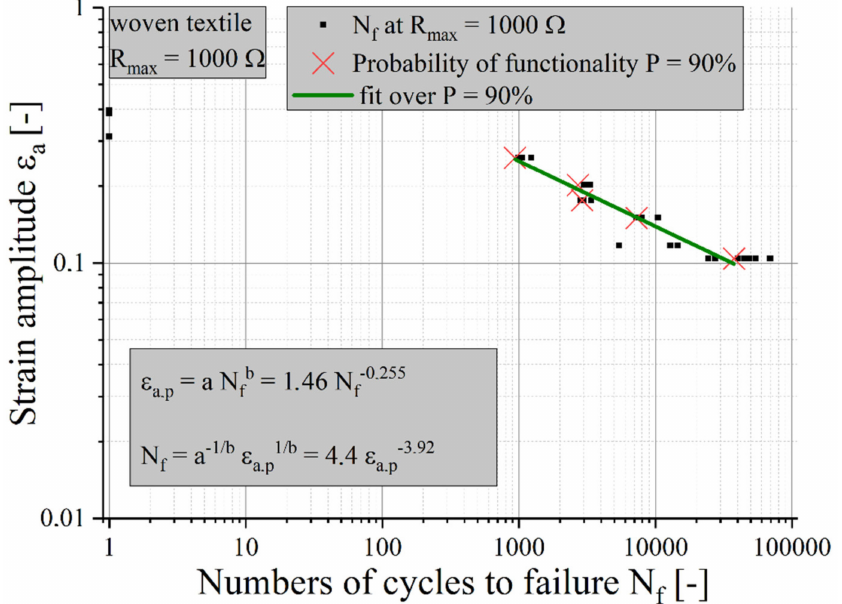
Figure 10. Life expectancy for elastic textile / polymer composite-based stretchable electronics with conductors made of silver-plated woven textiles under a cyclic mechanical load with R max = 1 k Ω . The results of the Co ffi n–Manson equations for samples with textile structures with the failure criterion of Rmax = 1 k Ω are shown in Figure 11. To compare the lifetime, the life expectancy of a sample with meandering copper tracks is added